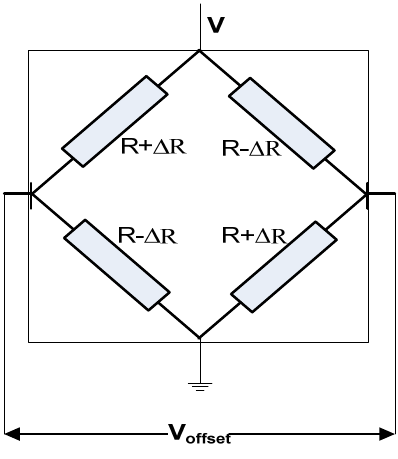
Figure 23. The bridge circuit model of a Hall